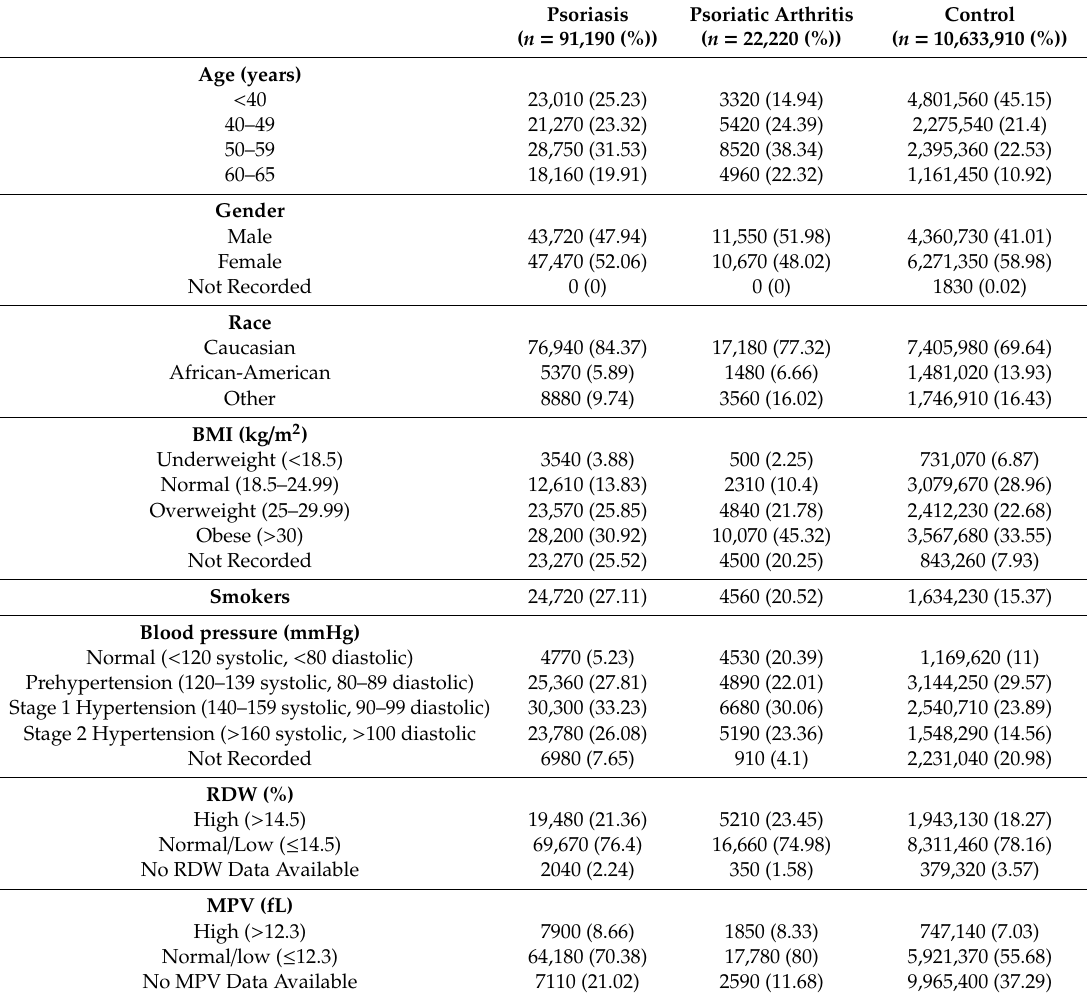
Table 1. Clinical and demographic characteristics of the cohort downloaded from Explorys database (Run date 07 / 09 /